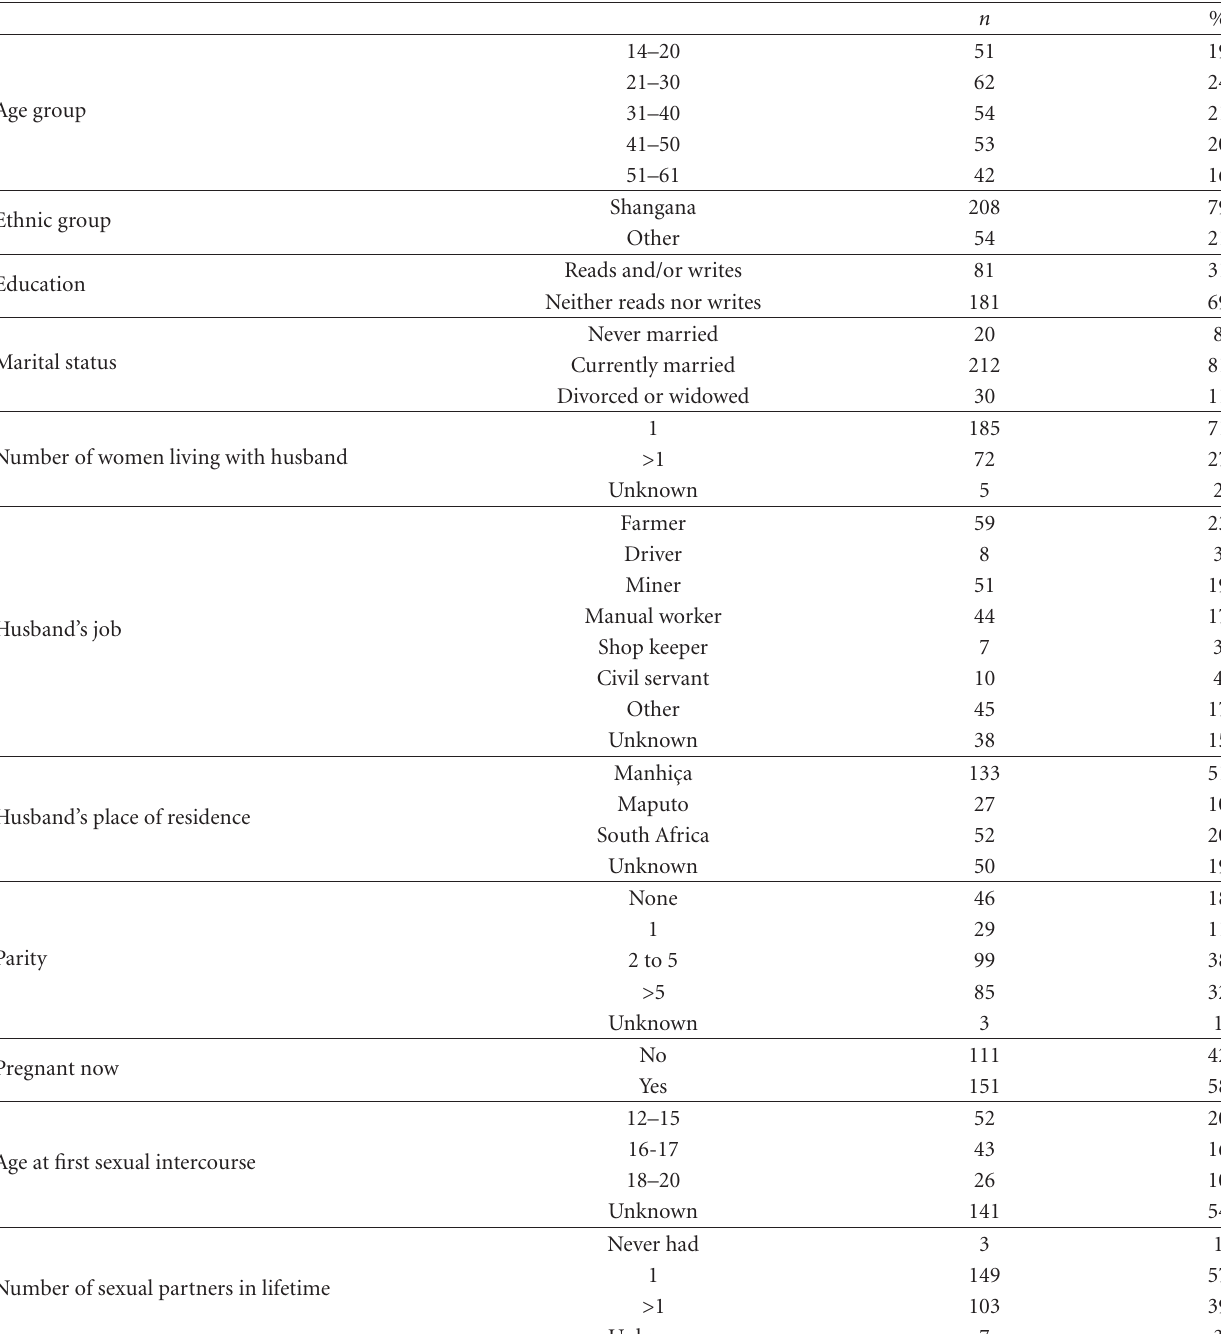
Table 1: Characteristics of the study